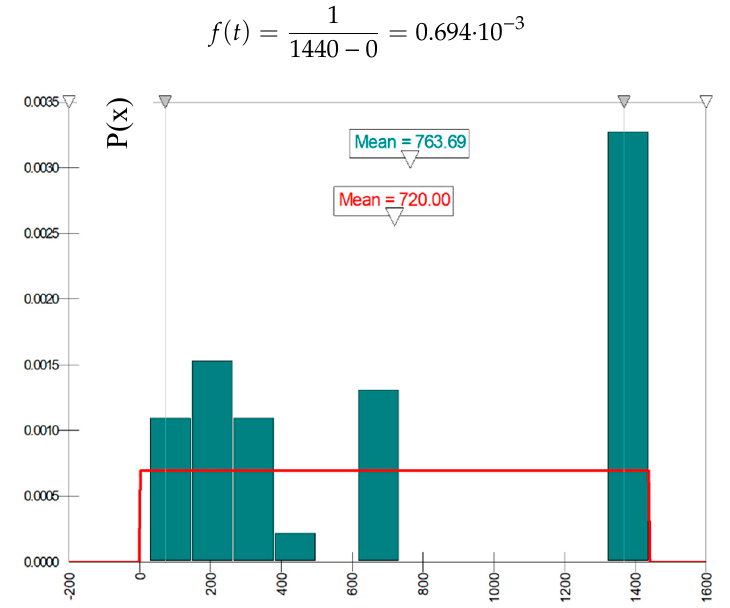
Figure 2. Time between two incoming satellite calls [min].